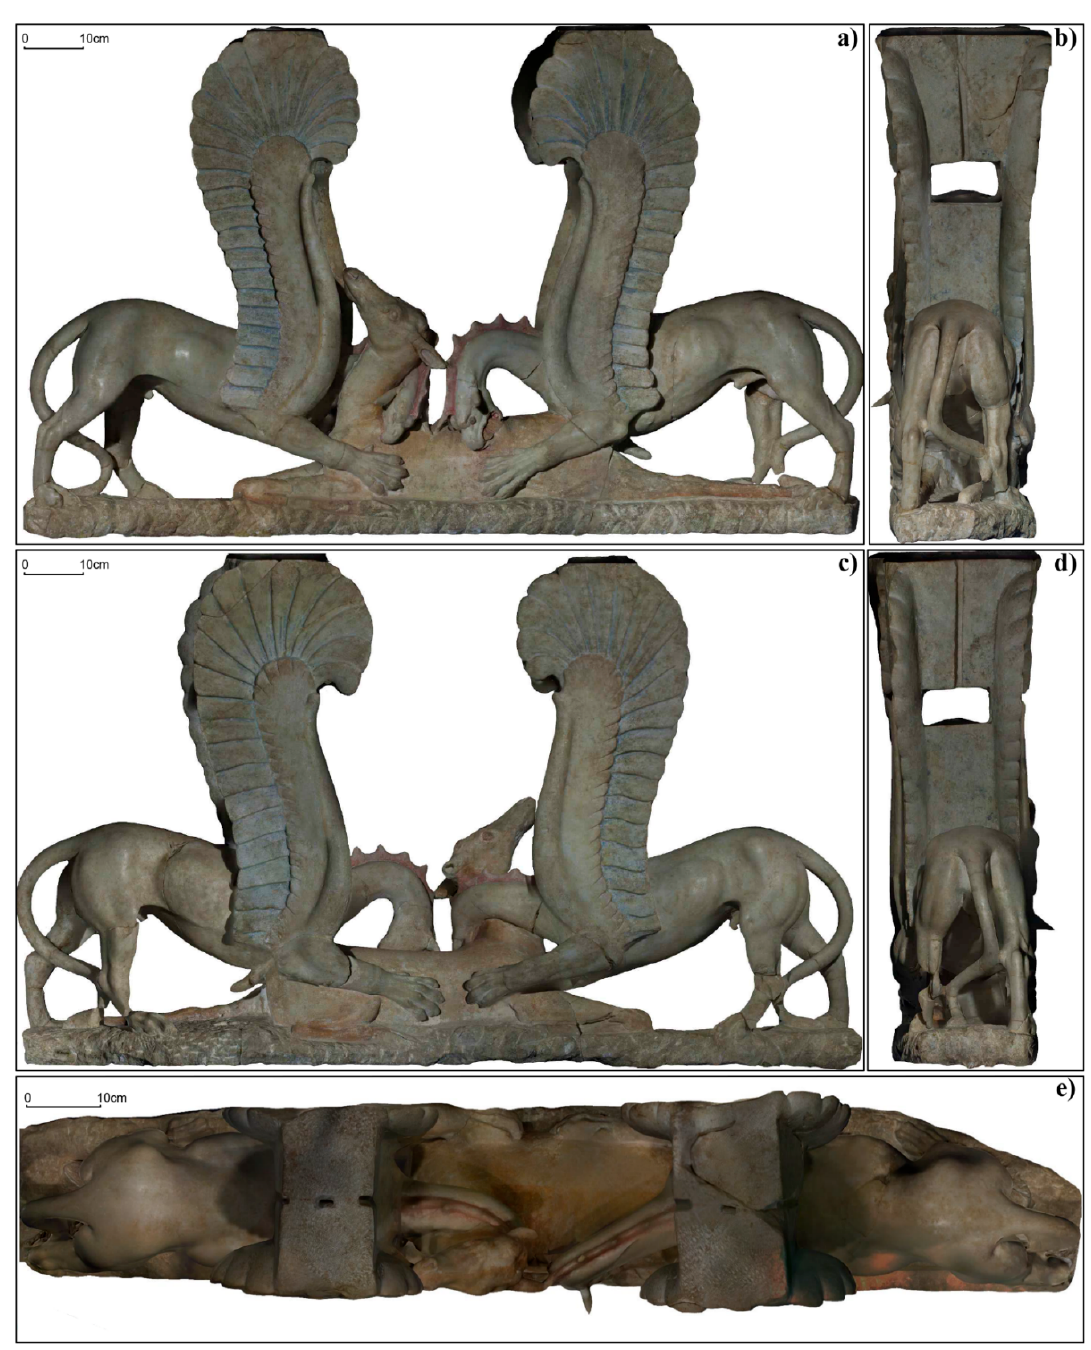
Figure 4. High-resolution orthophoto: front side ( a ), back side ( b ), right side ( c ), left side, ( d ) and top ( e ).